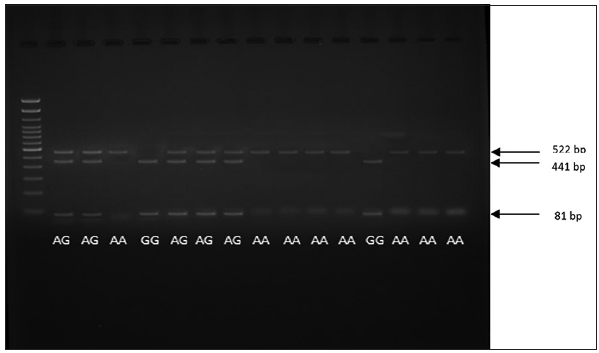
Figure-3: Leptin gene polymerase chain reaction- restriction fragment length polymorphism with restriction enzyme BsaA1.